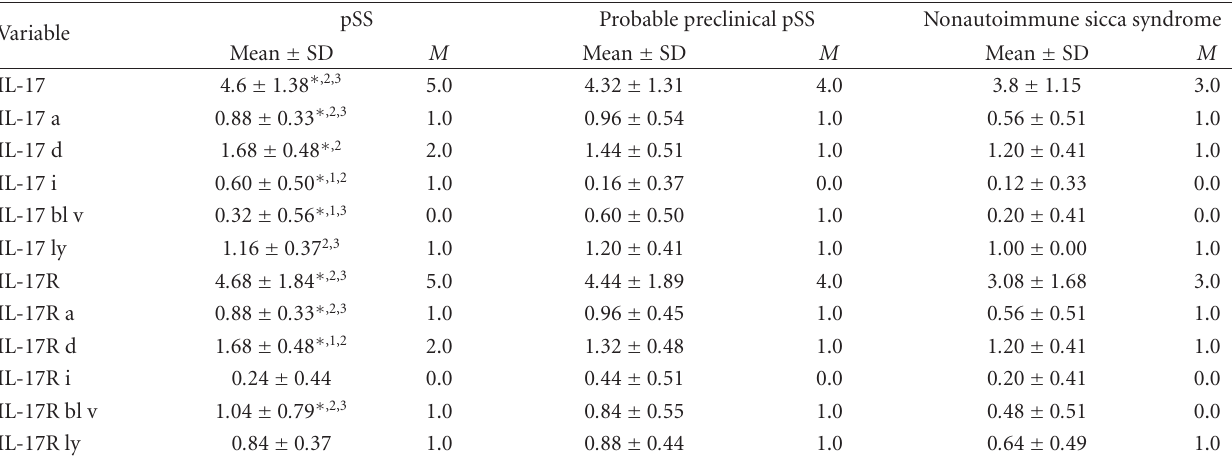
Table 2: Expression (grades) of IL-17 and IL-17R in minor salivary glands of patients with primary Sj¨ogren’s syndrome (pSS), with probable preclinical primary Sj¨ogren’s syndrome (probable preclinical pSS), and with nonautoimmune sicca syndrome: ducti (d), acini (a), blood